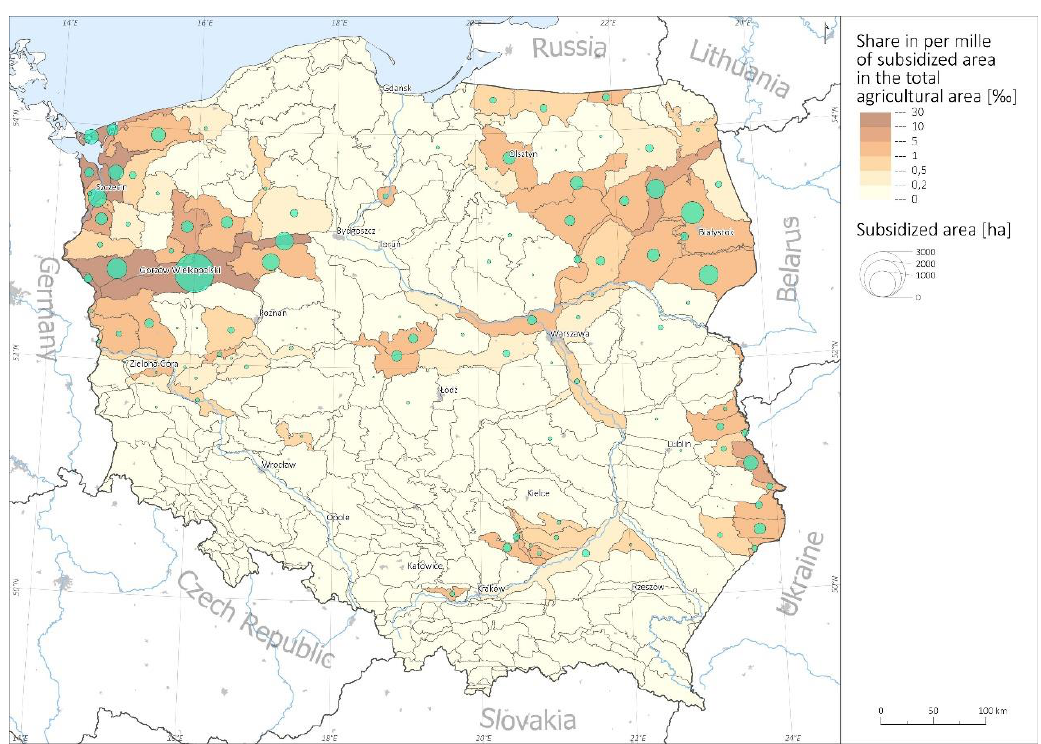
Figure 12. Area of land subsidised to support breeding habitats of the great snipe and Eurasian curlew, and their share in the total agricultural area in mesoregions (Source: Authors based on ARMA data).